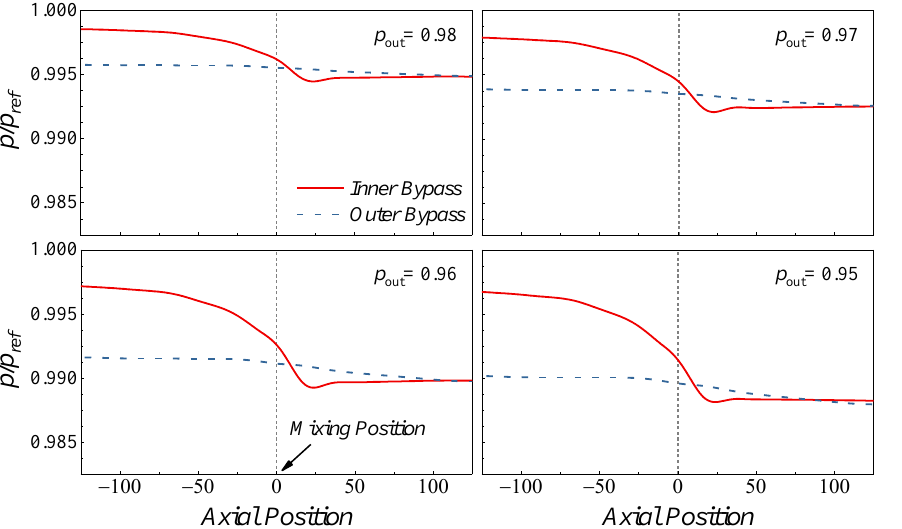
Figure 3. The validation of injection characteristics of the basic VABI model: ( a ) A VABI = 0.8; ( b ) A VABI = 0.6; ( c ) A VABI = 0.4.